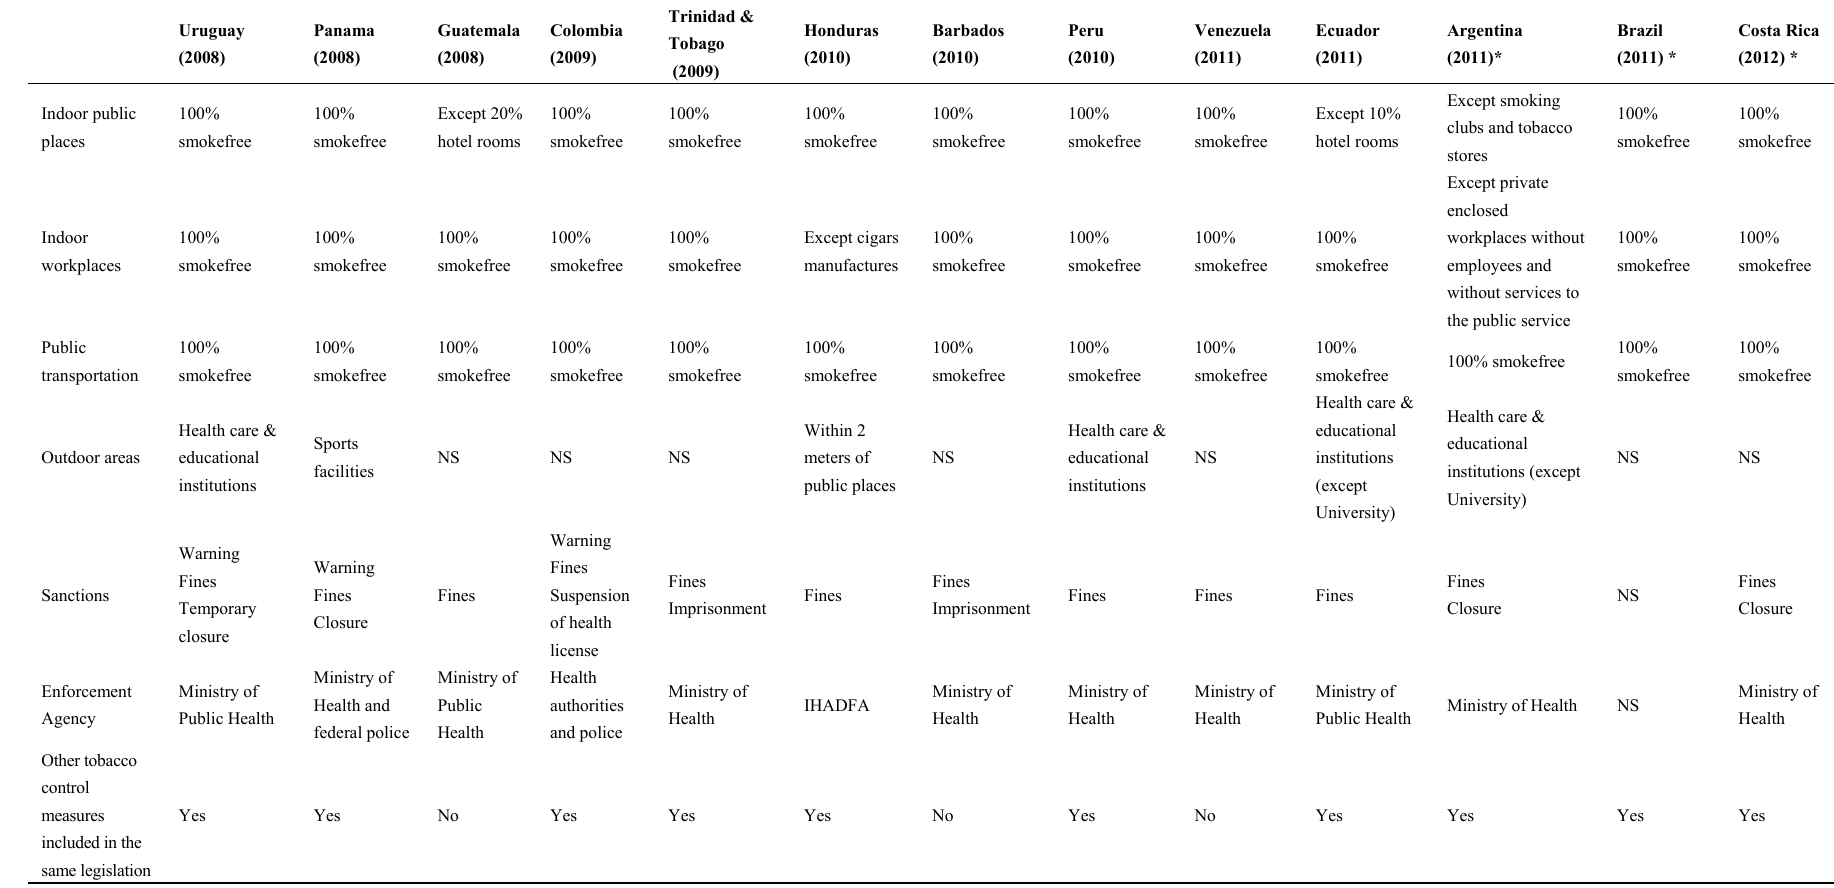
Table 1. Comparison of comprehensive national smokefree policies in Latin America and the Caribbean